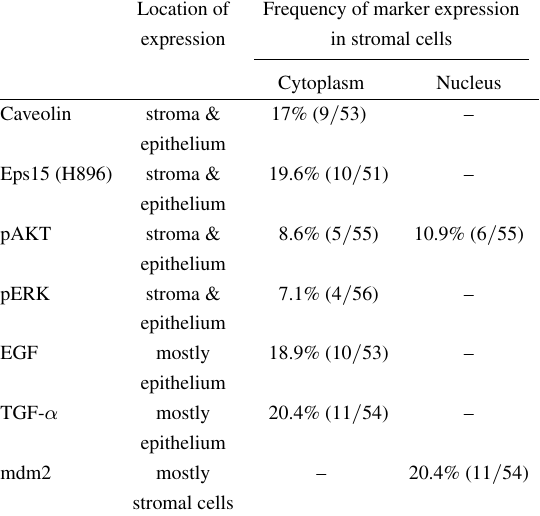
Overview about the frequencies of immunohistochemical staining of the investigated molecular markers Location of Frequency of marker